Question: Which kind of chart has been used to present this data?
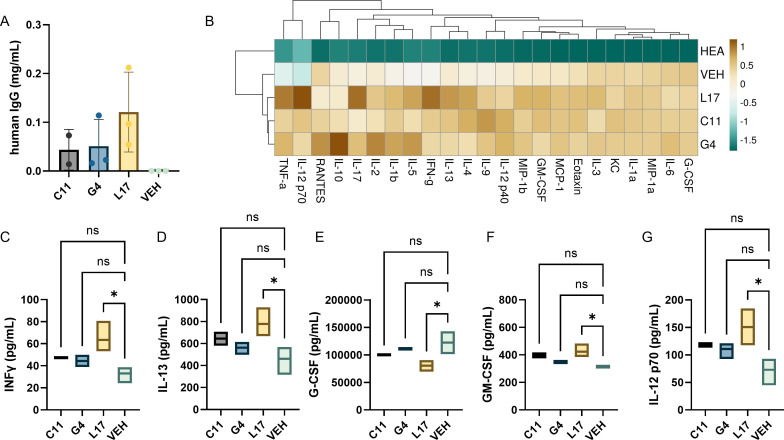
Answer: heatmap